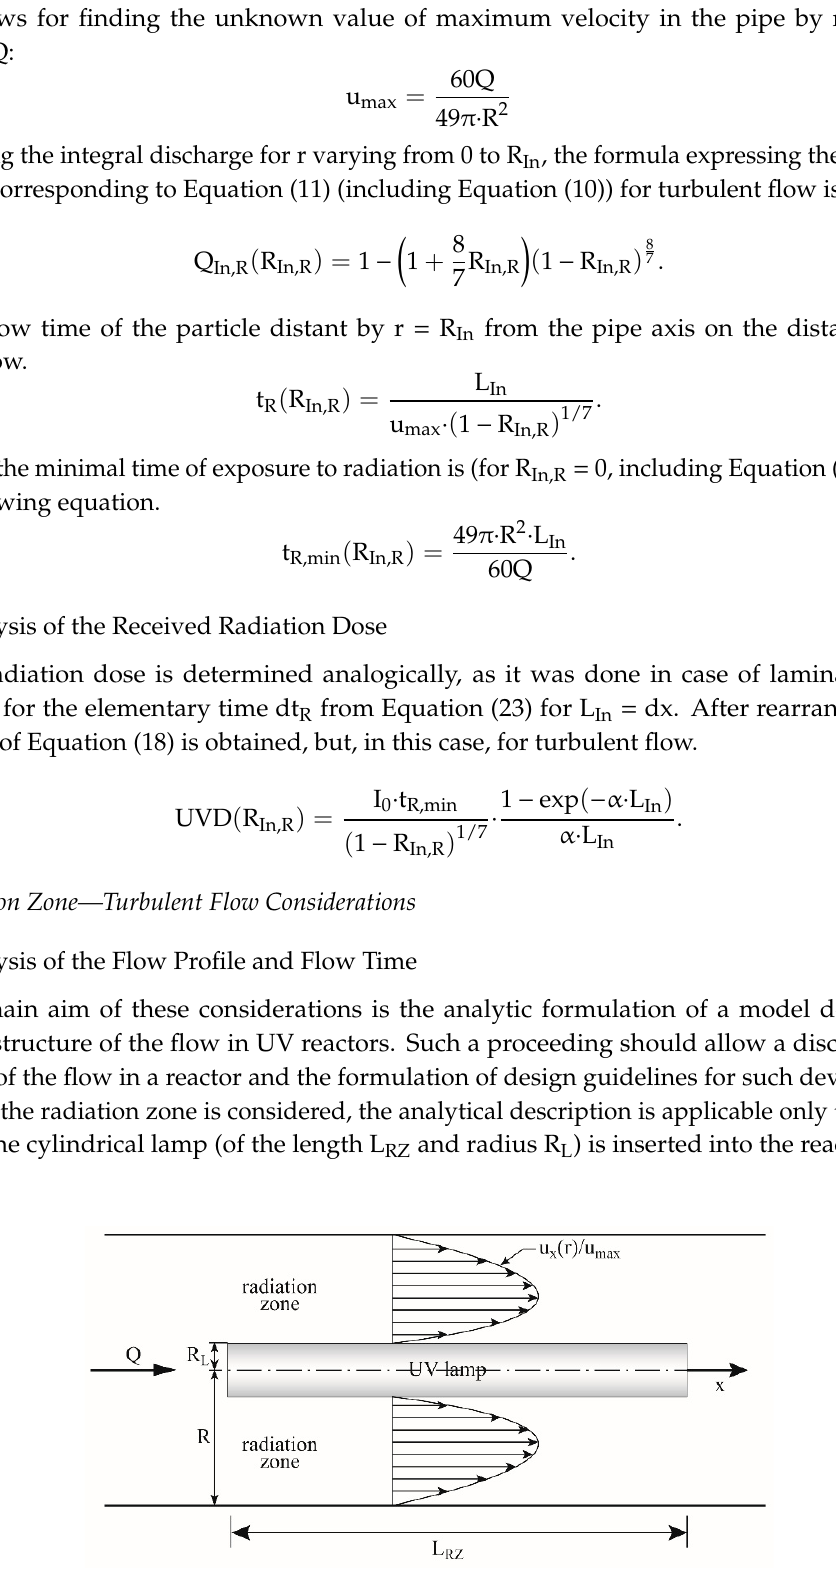
Figure 3. The flow profile in the radiation zone (R = 0.1 (m), R L = 0.02 (m), u max = 0.07 (m · s -1 ), C L = 20 (m -1 · s -1 )).